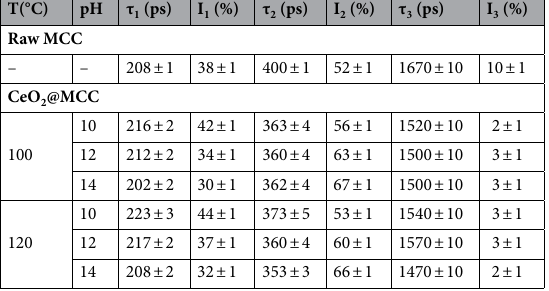
Table 3. Characteristic positron lifetimes and associated intensities obtained from the decomposition of PALS spectra for the raw MCC sample and the CeO 2 @MCC samples under different synthesis parameters.